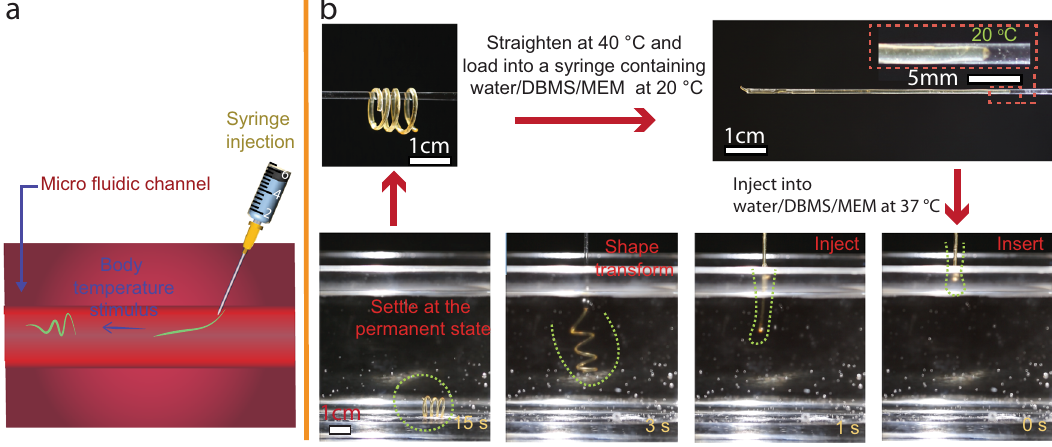
Fig. 6 | Application demo of halogen-bonded shape memory polymer. a A schematic representation of shape recovery of an injected temporary shape by body temperature stimulus. b Photographs illustrating the original coil shape (top